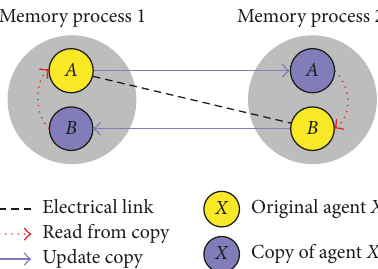
Figure 1: RepastHPC’s agent copy and update synchronization.